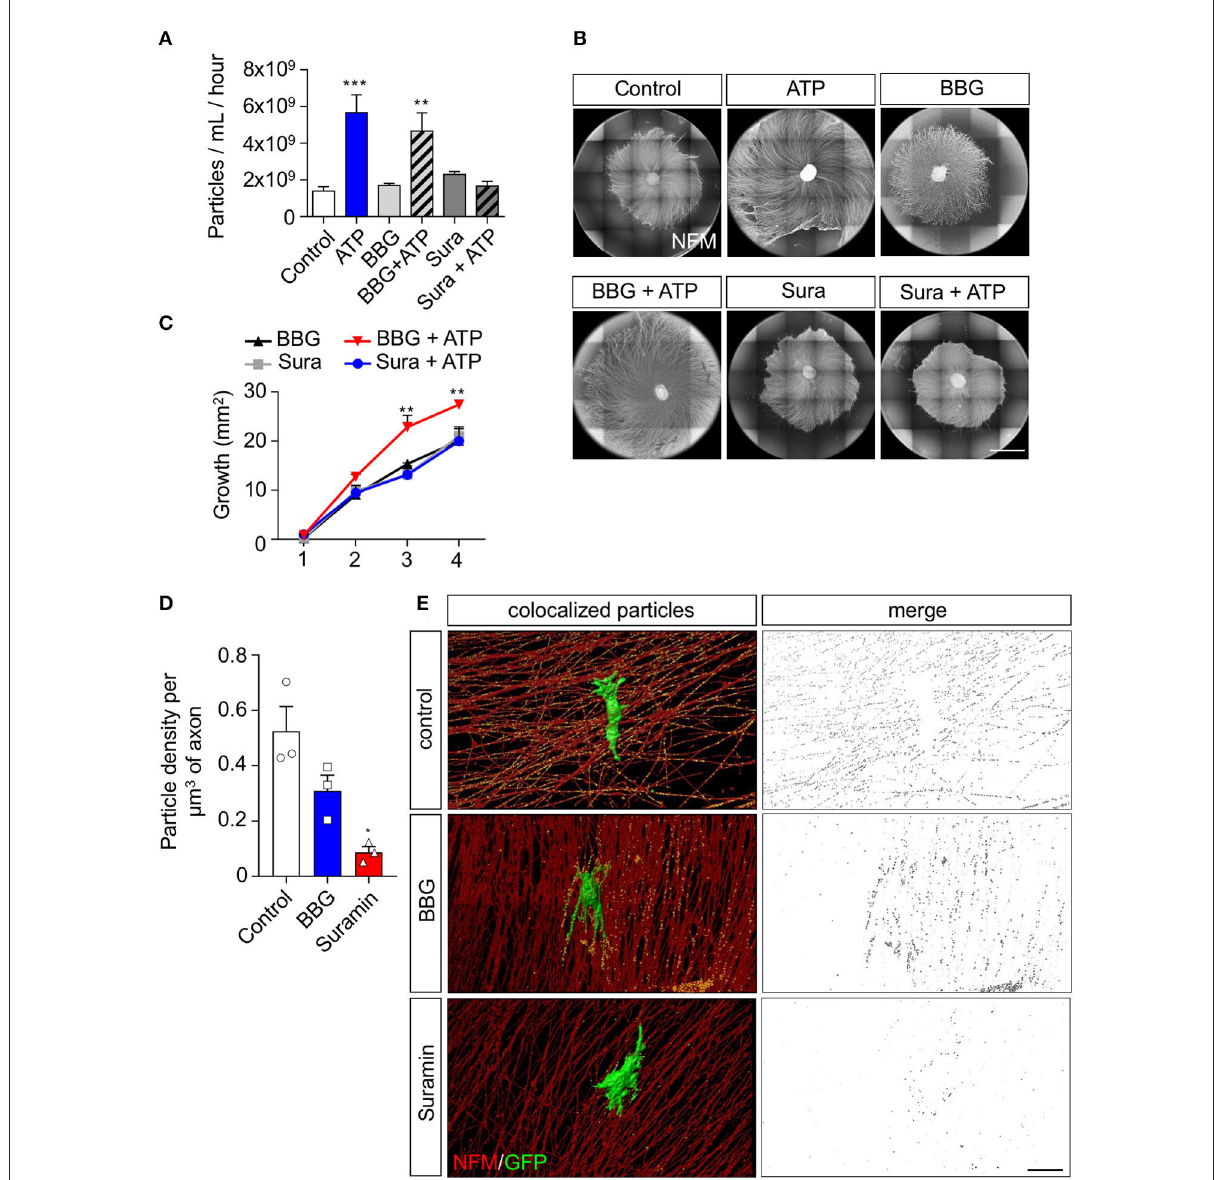
FIGURE3 P2Y family of receptors is involved in the increased sEV release and axonal elongation effect of ATP on rSC. To analyze to which receptor ATP binds to exert its effect on rSC we pharmacologically inhibited P2X7 or P2Y receptors and analyzed the sEV released by NTA and their effect on axonal growth in DRG after ATP treatment. (A) Conditioned media from 8h after ATP and drug treatment were measured by NTA to analyze the rate of release of sEV from rSC. (B,C) The effect of sEV from rSC treated with or without ATP in the presence of BBG or suramin on neurons was analyzed by daily treatment of DRG with 0.5 µ g of sEV. The elongation effect on DRG was visualized on day 4 by immunofluorescence using neurofilament medium (NFM) immunostaining in axons. Scale bar, 1,500 µ m. (D,E) Co-cultured DRG neurons with rSC expressing CD63-GFP to visualize EVs were analyzed for EV transfer by immunofluorescence after incubation with BBG or suramin and detection of GFP signal in axons. Scale bar, 20 µ m. In all quantifications, average and SEM of at least three independent experiments are shown (*** p < 0,0001; ** p < 0.001; * p <